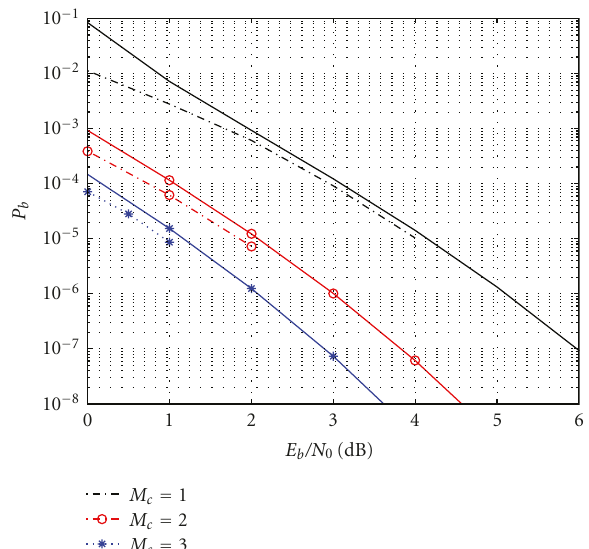
Figure 3: Bit-error probability of convolutionally coded GSC with M = 4 in Nakagami fading with m = 2 (solid: bound, dashed: simulation).